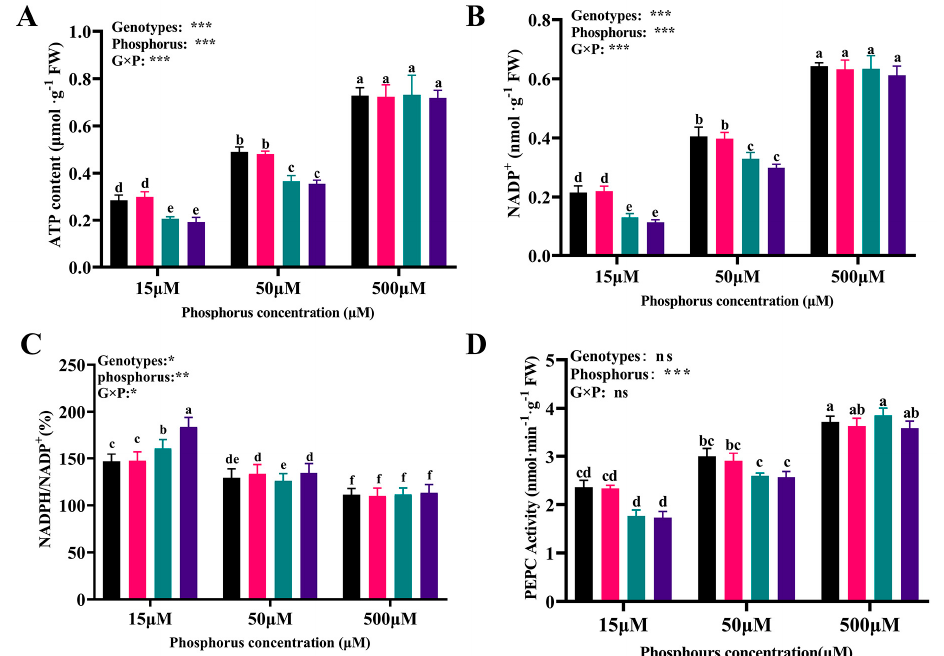
Figure 5. Effects of different P treatments on the availability and quantity of photosynthesis-related enzymes. ( A ) ATP (adenosine-triphosphate) content, ( B ) NADP + (nicotinamide-adenine- dinucleotide- phosphate) content, ( C ) NADPH/NADP + , and ( D ) PEPC (phosphopyruvate-carboxylase) activity in the cotton genotypes, fully expanded barley leaves. The results are expressed as means ± SE ( n = 7). Statistically significant changes are indicated by different letters, using the two-way ANOVA and multiple-comparison test ( p ≤ 0.05). p -values of the ANOVAs of genotypes (G), phosphorus level (P), and their interaction (G × P) are indicated as ns, not significant; *: p < 0.05, **: p < 0.01, ***: p <